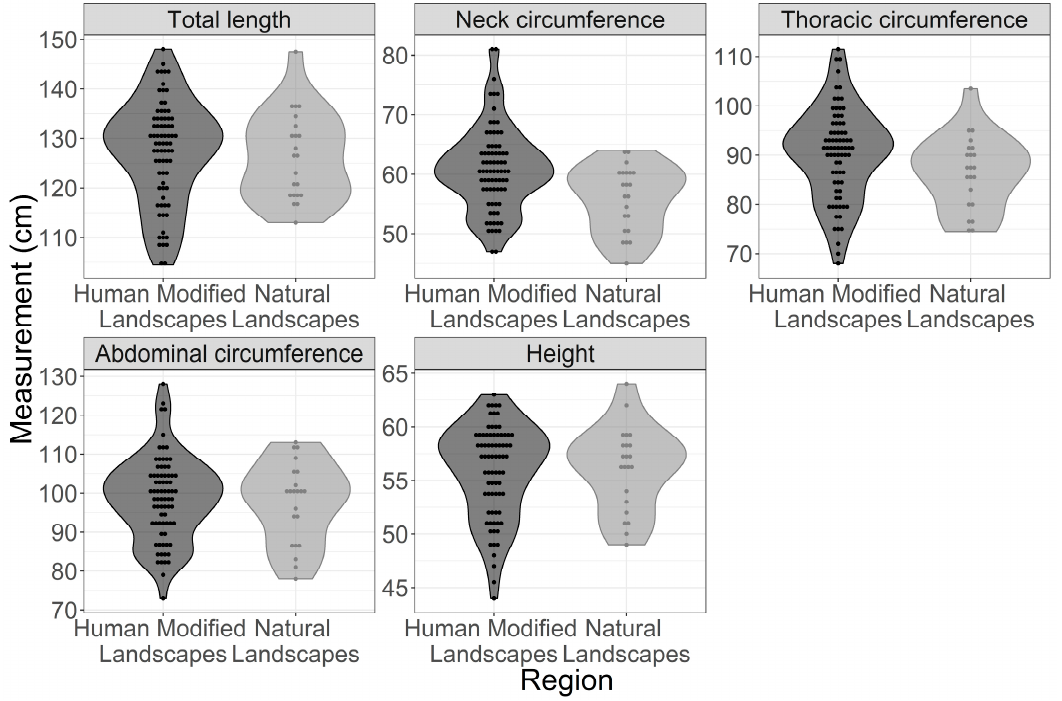
Figure 3. Graphical representation of individual values of five types of body measurement of adult capybaras, according to the study region (landscape type). Table 3. Comparison of biometric parameters between capybaras from human-modified landscapes (HMLs) and natural landscapes (NLs).